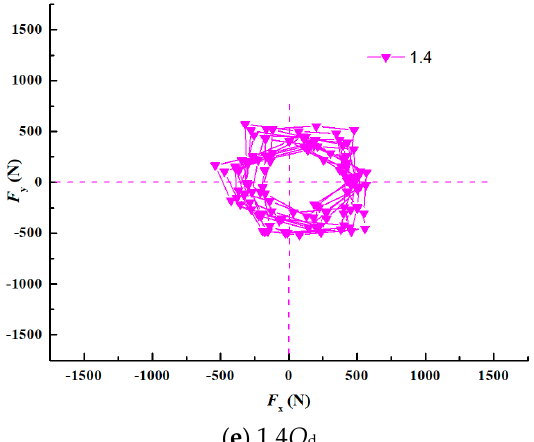
Figure 8. Rotor radial force vector distribution at different flow rate conditions.